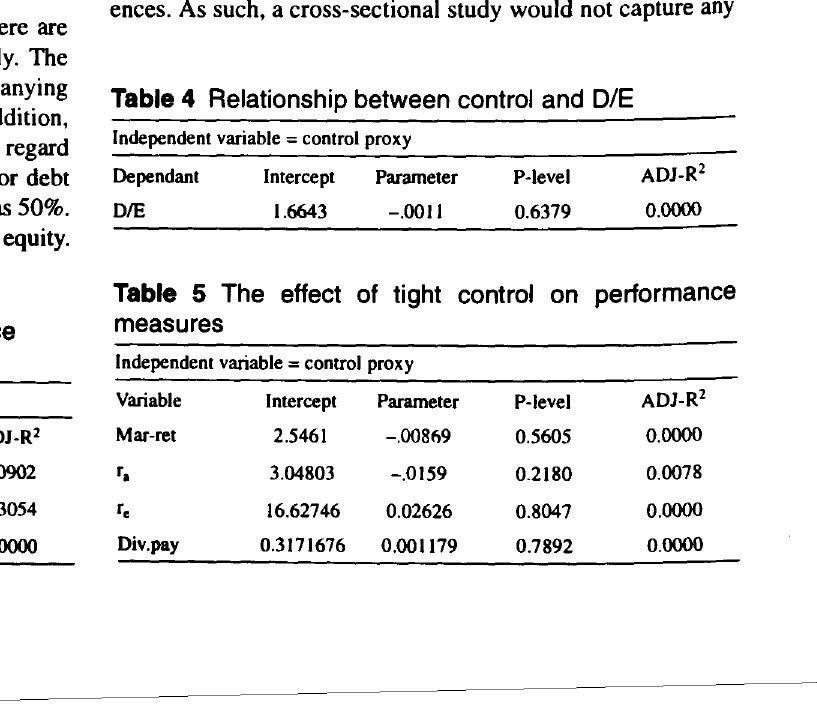
Table 4 Relationship between control and 0/E